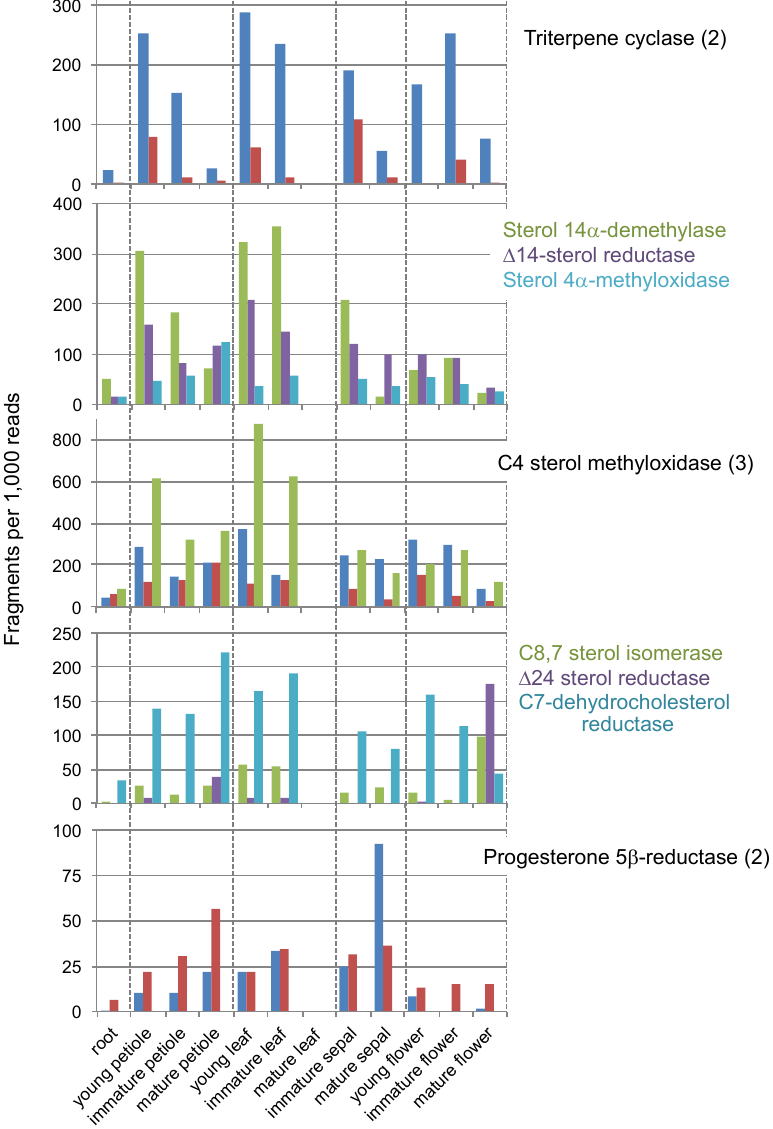
Figure 14. The expression profile of contigs from D. purpurea with sequence similarity to cardenolide metabolic